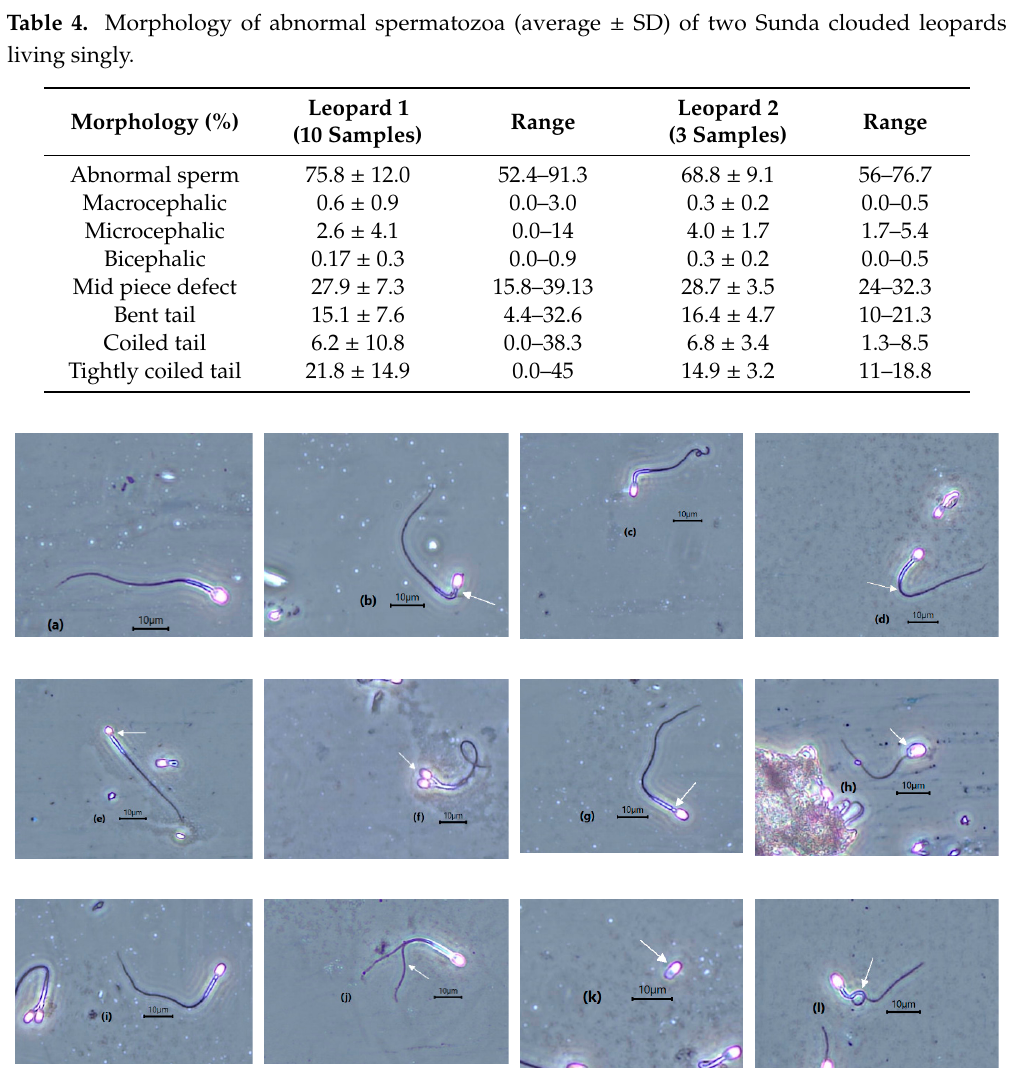
Figure 3. Photomicrograph image of Sunda clouded leopard spermatozoa under phase contrast microscopy (white arrows are pointing out the defects). ( a ) Normal spermatozoa, ( b ) bent midpiece, ( c ) coiled tail, ( d ) bent tail, ( e ) microcephalic, ( f ) bicephalic, ( g ) cytoplasmic droplet, ( h ) macrocephalic, ( i ) irregular shaped tail, ( j ) double tail, ( k ) detached head, and ( l ) shoe-hook tail.